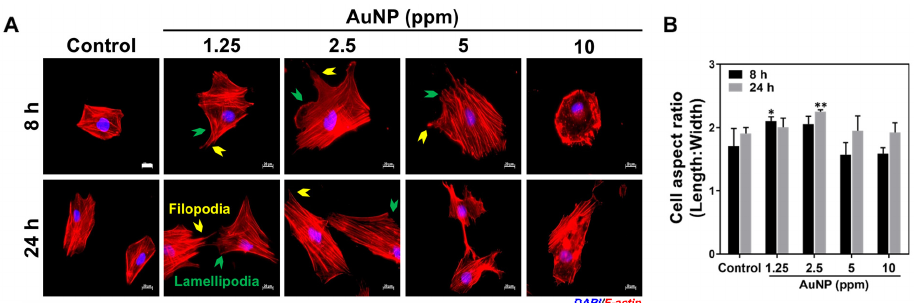
Figure 4. Cell morphology of MSCs influenced by AuNPs after 8 and 24 h of incubation. ( A ) The F-actin fiber of MSCs was stained by rhodamine phalloidin (red fluorescence) in each treatment. Yellow arrows indicate filopodia, while green arrows represent lamellipodia. DAPI was applied for cell nuclei detection. Scale bar = 20 μ m. ( B ) The quantitative results of the cell aspect ratio for each treatment. The images are displayed as one of three independent experiments. The quantified results are exhibited as mean ± SD ( n = 3). * p < 0.05, ** p < 0.01: compared to the Control group (TCPS).